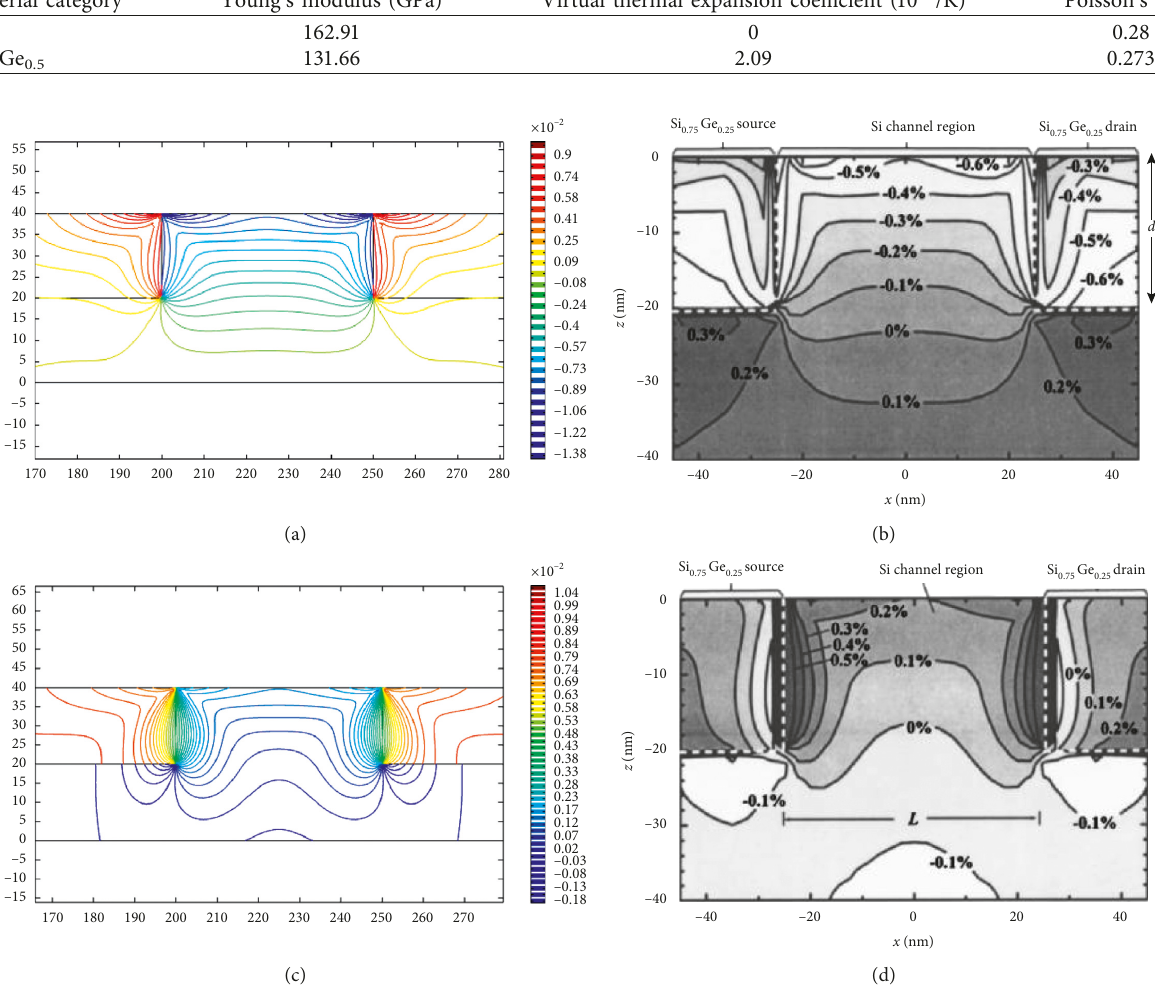
xx simulation result. (b) ε xx reference result.